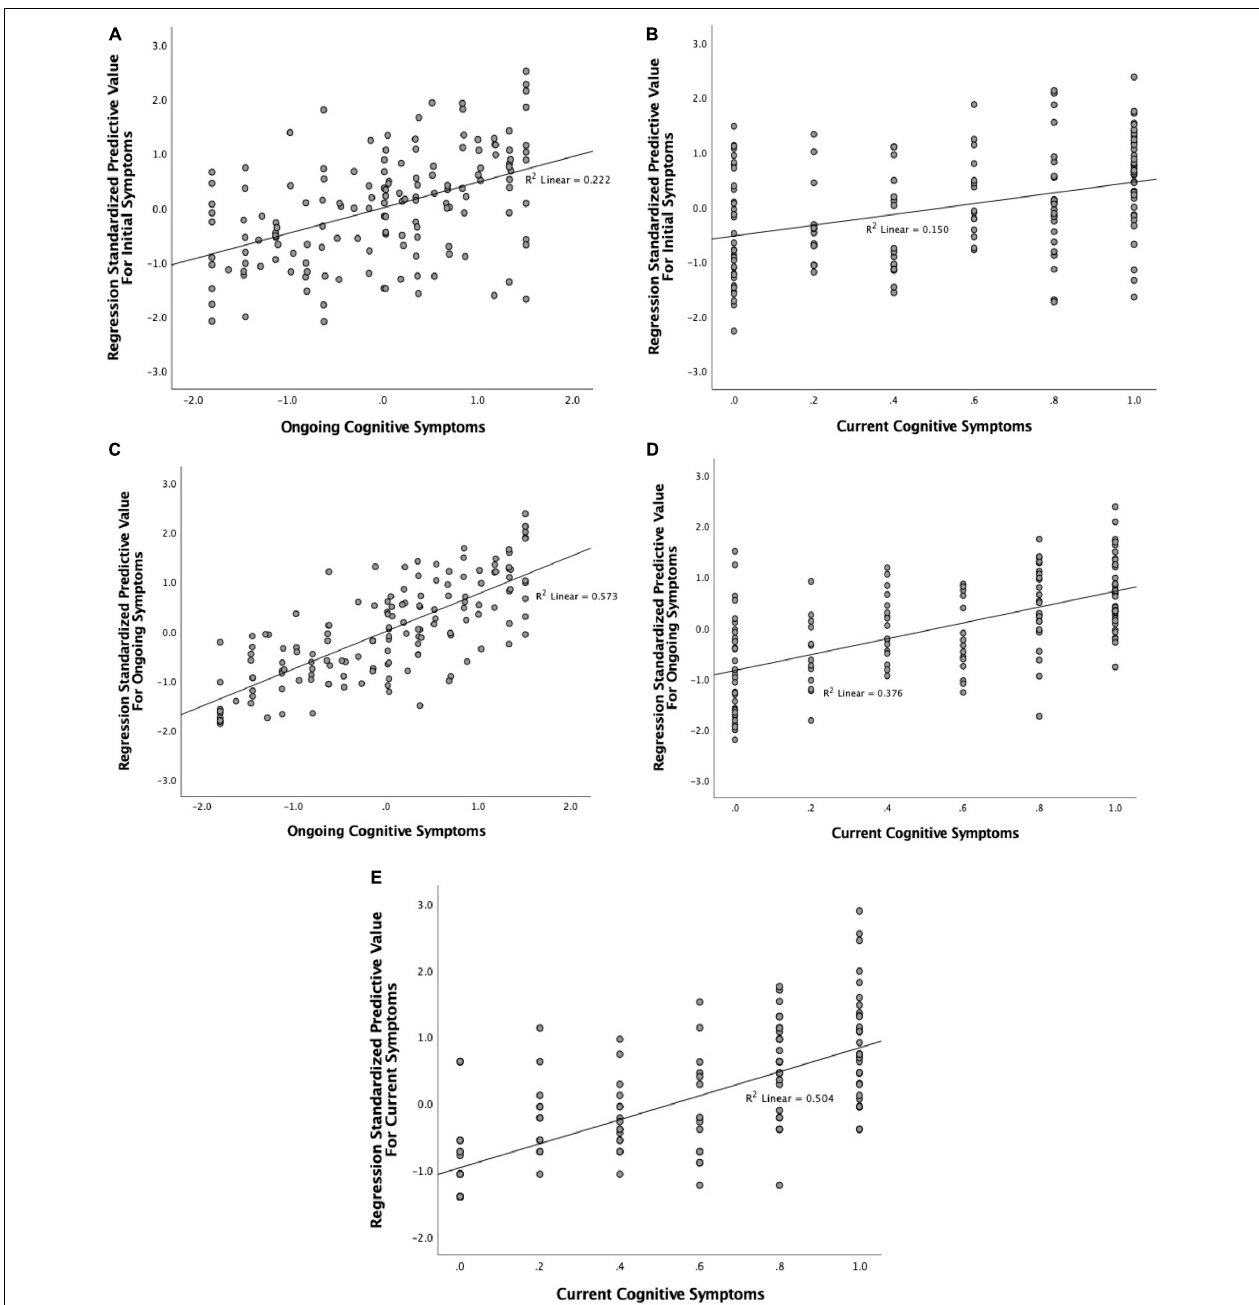
FIGURE 8 | Association between combined regression model predicted value for (A) initial symptom factors and ongoing cognitive symptoms; (B) initial symptom factors and current cognitive symptoms; (C) ongoing symptom factors and ongoing cognitive symptoms; (D) ongoing symptom factors and current cognitive symptoms; and (E) current symptom factors and current cognitive